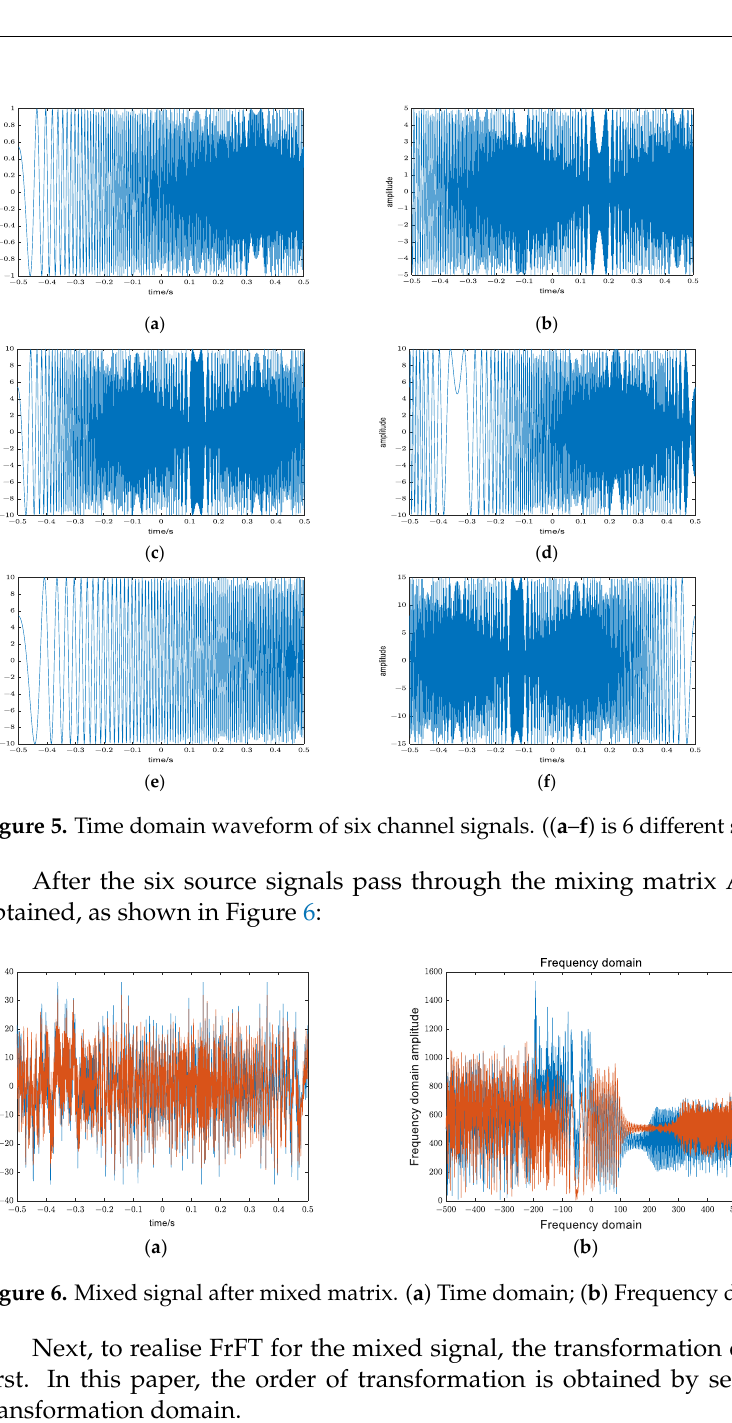
( d ) Figure 7. Change of mixed-signal sparsity of the first receiving channel with order. ( a , b ) Rough search result; ( c , d ) Exact search result.